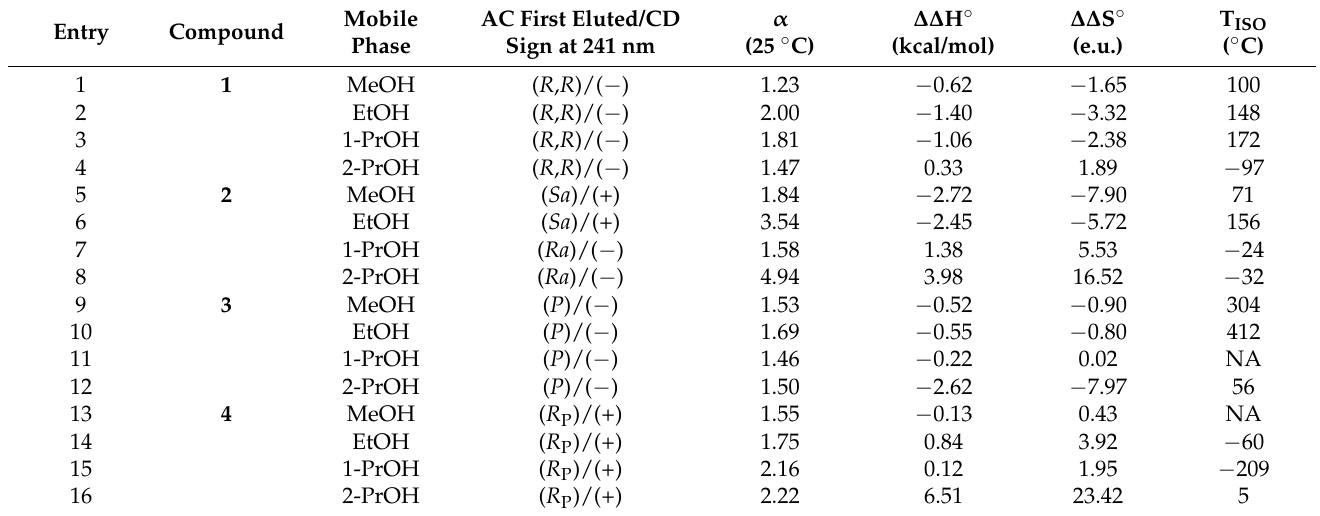
Table 1. Absolute configuration (AC) of the first eluted enantiomer, enantioseparation factors at 25 ◦ C, and thermodynamic data of 1 – 4. Chromatographic conditions: column, Chiralpak